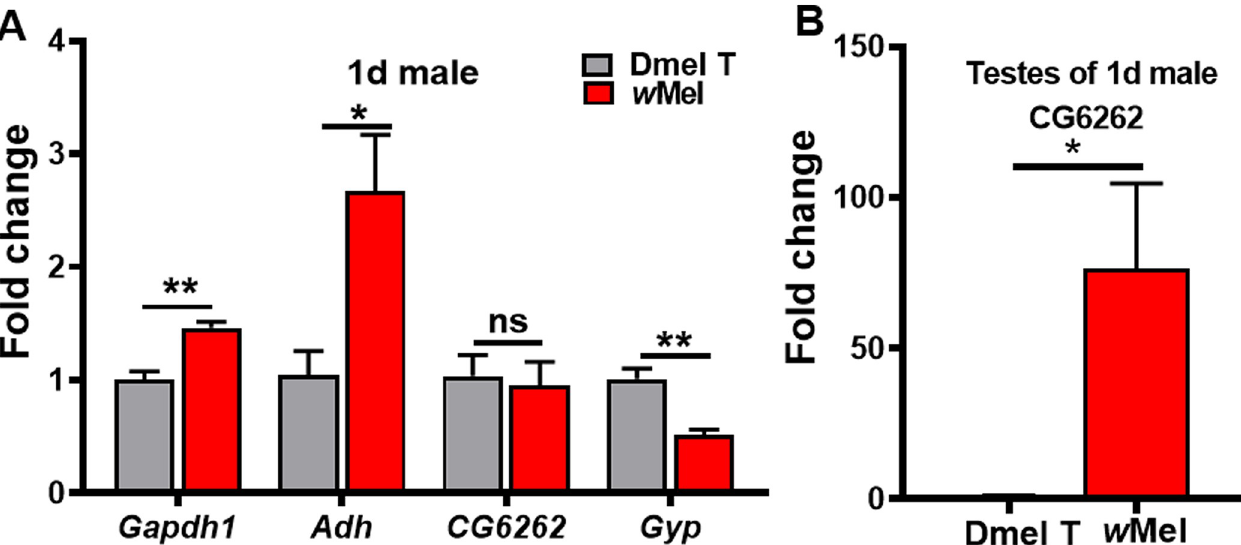
Fig 4. Wolbachia infection caused changes in mRNA levels of some glycometabolism associated genes in 1d male flies (A) and 1d male fly testes (B). Dmel T: uninfected flies; w Mel: Wolbachia -infected flies. � P < 0.05; �� P < 0.01.